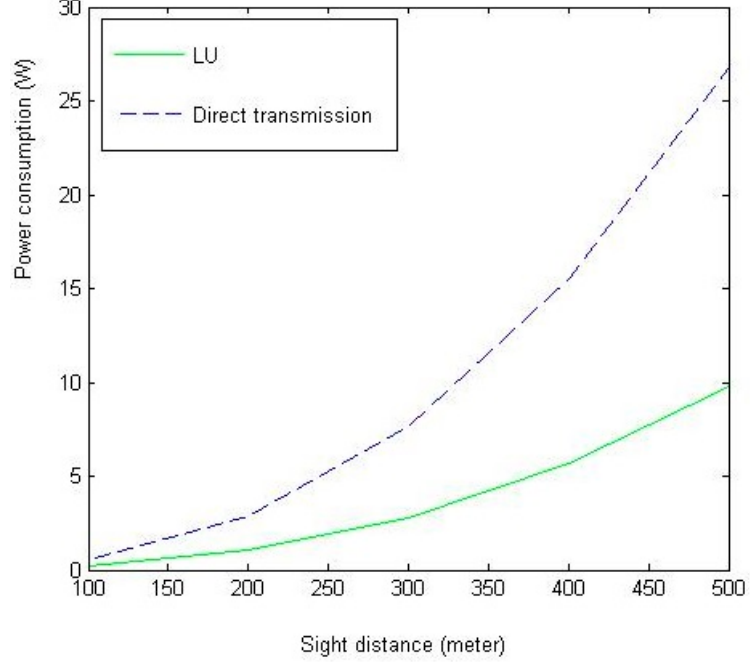
Figure 3. The impact of T on system power consumption (the amount of total power needed in system under different configurations of sight distance).